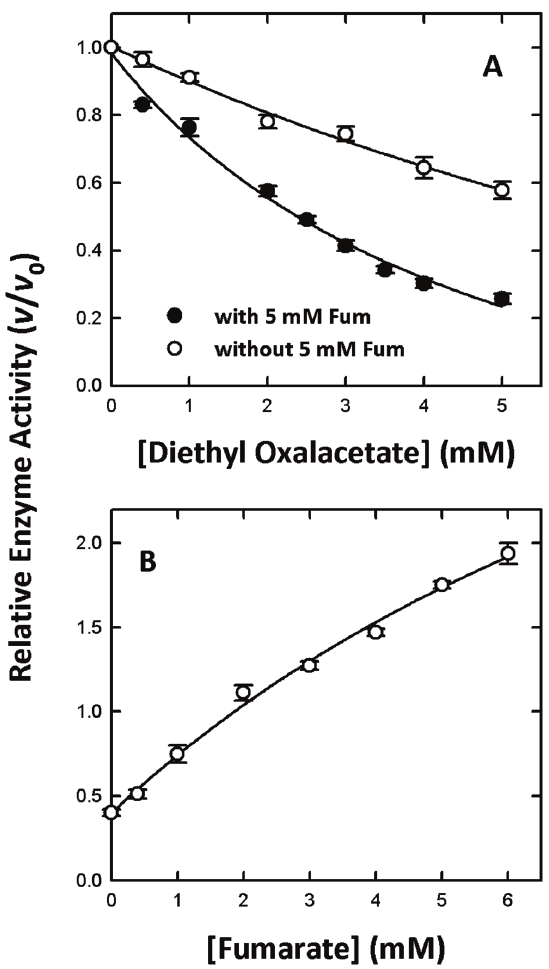
Figure 4. Effect of fumarate on diethyl oxalacetate-inhibited m- NAD(P)-ME activity. (A) The diethyl oxalacetate inhibition experiment of WT m-NAD(P)-ME without (closed circles) or with (open circles) 5 mM fumarate. (B) The fumarate rescue experiment of WT m-NAD(P)-ME. The enzyme was preincubated with 3 mM diethyl oxalacetate, and then the activity was restored with increasing concentrations of fumarate.